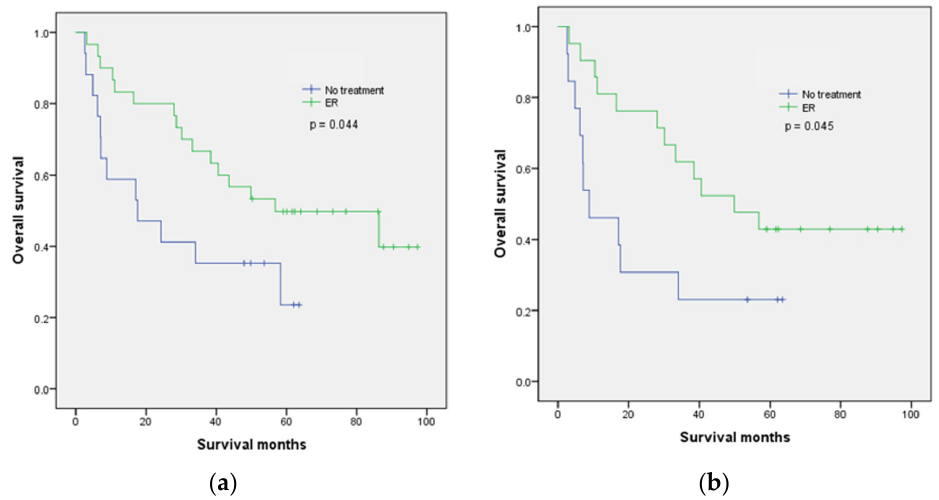
Figure 2. Kaplan–Meier survival curve shows the overall survival of the two groups: ( a ) overall patients; ( b ) advanced head and neck cancer patients .